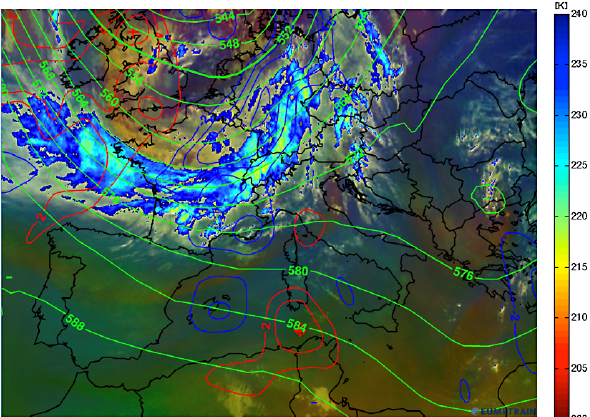
Figure 2. Synoptic analysis over the western Mediterranean region at 06:00UTC, 12 September 2012: ECMWF 500hPa geopotential height (green lines), 700hPa temperature advection (red warm and blue cold), MSG SEVIRI AirMass RGB composite EumetSat prod- uct and enhanced IR 10.8µm temperature, ranging between 200K (red) and 240K (blue). Source: